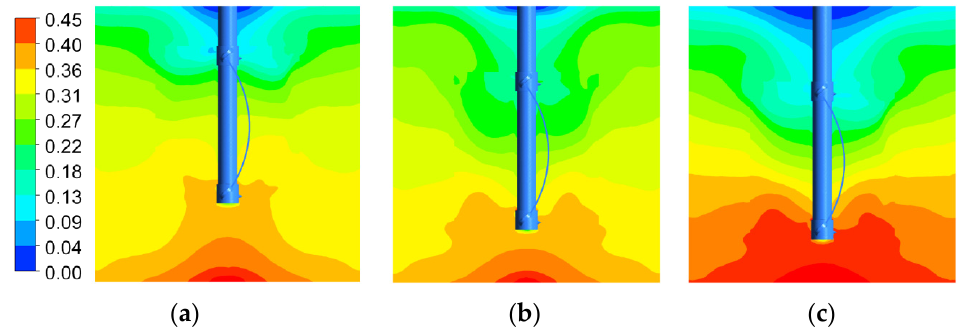
Figure 22. Contour plots of solid distribution for DRFTBI with different off-bottom clearance. ( a ) T/3; ( b ) T/4; and ( c ) T/5. (Rotational speed: 120 rpm; solid loading: 30%; connection strap length: 1.2 Hs).